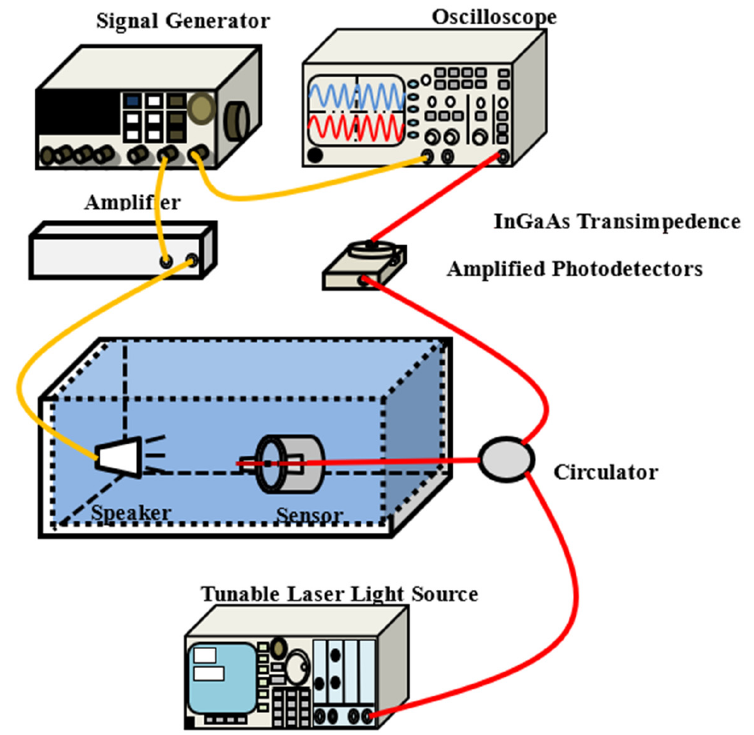
Figure 2. The experimental setup of using FBG hydrophone to detect low-frequency acoustic waves.